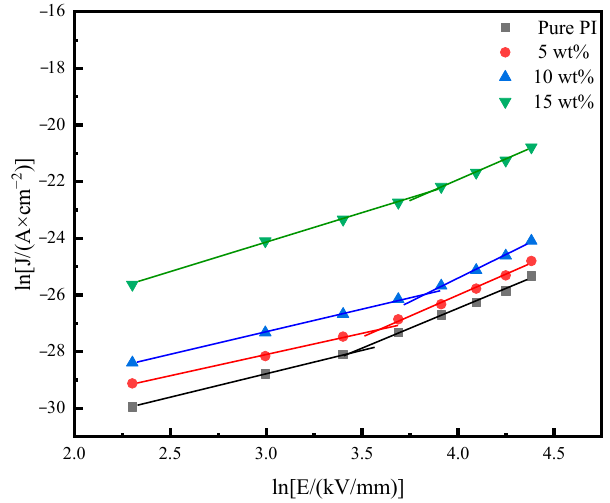
Figure 7. Conductivity and current characteristics of pure film and PI/SiO 2 composite films with different doping amounts at 155 °C. Table 1. Electrical aging thresholds of pure PI films and PI/SiO 2 three-layer composite films with different doping amounts.